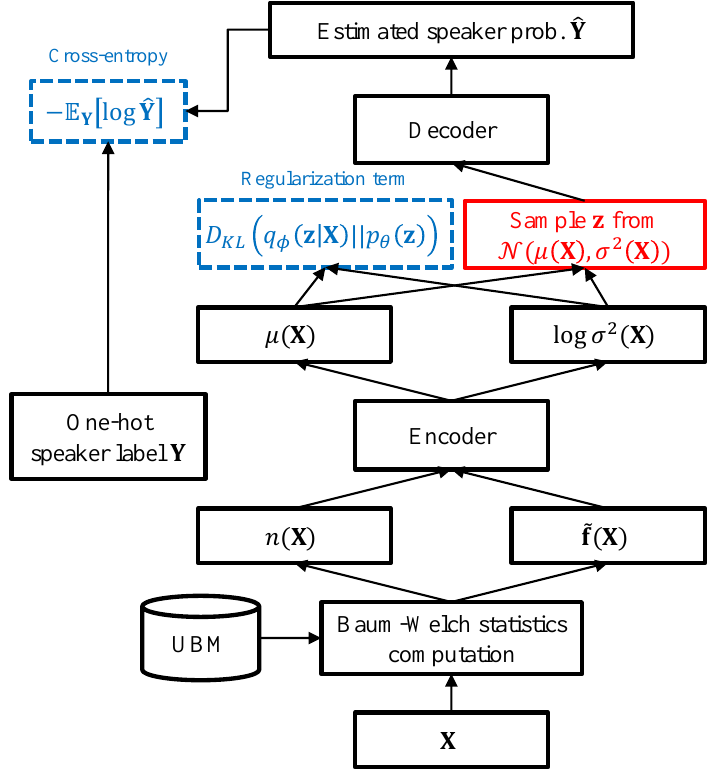
Figure 4. Network structure of the baseline VAE Classify